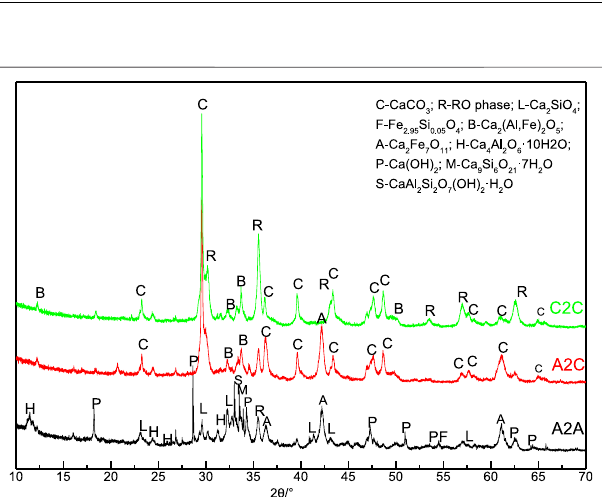
FIGURE 5 | X-ray diffraction patterns of the uncarbonated area sample from A2A-28d, carbonated area samples from A2C, and C2C in 1d curing age. (C, R, L, B, A, H, P, M, and S denote calcite (CaCO 3 ), RO phase, larnite (Ca 2 SiO 4 ), brownmillerite (Ca 2 (Al,Fe) 2 O 5 ), calcium iron oxide (Ca 2 Fe 7 O 11 ), hydrocalumite(Ca 4 Al 2 O 6 · 10H 2 O), portlandite(Ca(OH)2), metajennite (Ca 9 Si 6 O 21 · 7H 2 O), and lawsonite (CaAl 2 Si 2 O 7 (OH) 2 · H 2 O),